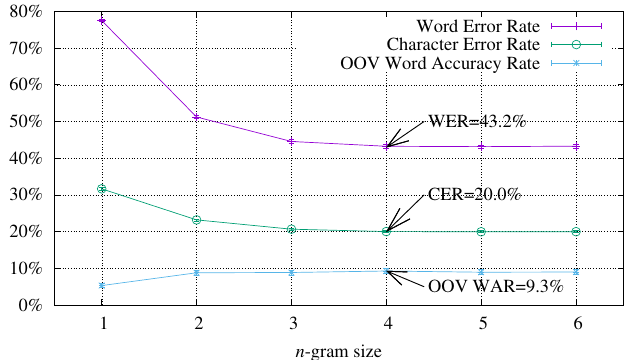
Figure 8. Results obtained by decoding at the HMM sub-word level by using n -gram language models with size n = { 1, . . . ,6 } .